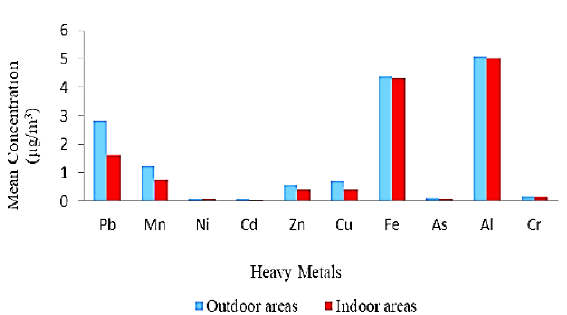
Fig. 5. Mean concentration of heavy metals in outdoor and Indoor